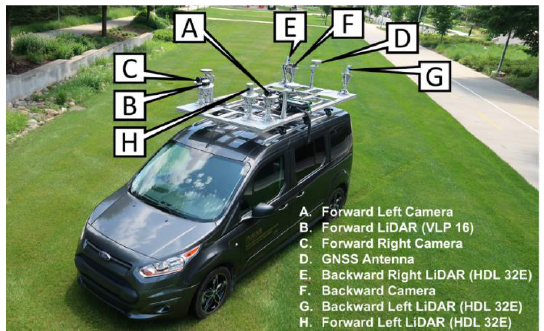
Figure 1 The wheel-based mobile mapping systems (MMS) used in this research